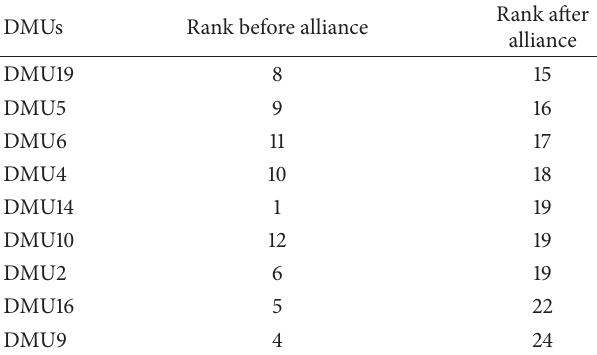
Table 15: The impossible alliance partners.